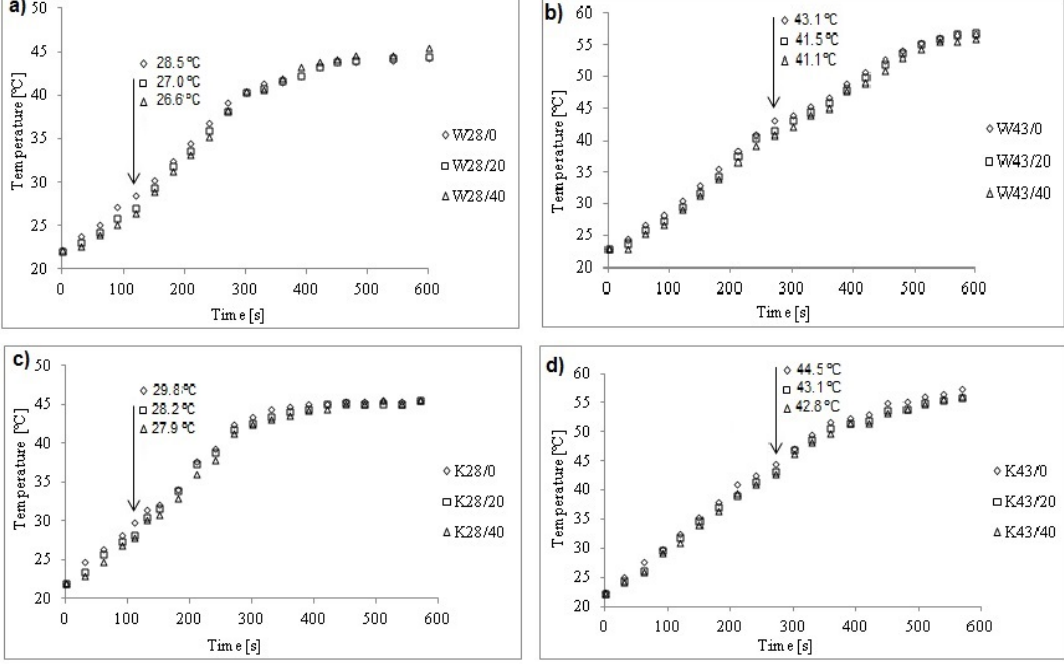
Figure 5. The temperature dependence on heating time for: a ) woven fabrics W28/0, W28/20, W28/40; b ) wovenfabrics W43/0, W43/20, W43/40; c ) knitted fabrics K28/0, K28/20, K28/40; d ) knitted fabrics K43/0, K43/20, K43/40.